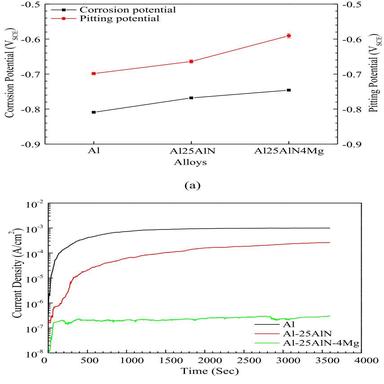
(a) Effect of Mg and AlN composites on corrosion and pitting potentials and (b) Changes of current densities with time during −660 mVSCE application for Albased, Al-25AlN, and Al-25AlN-4Mg alloys in 0.1 M NaCl solution.